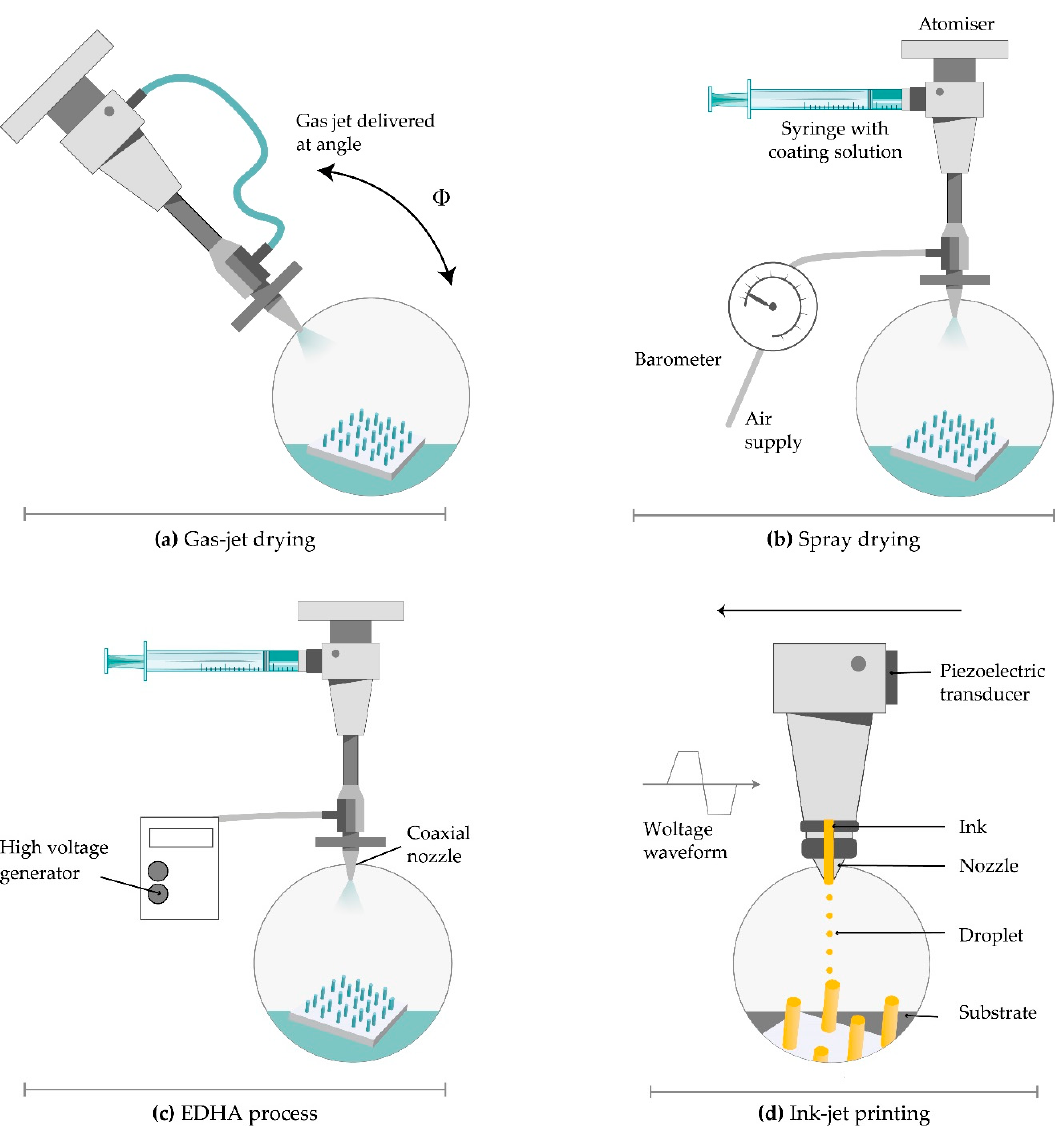
Figure 9. Coating techniques for MNs. ( a ) gas-jet drying; ( b ) spray drying; ( c ) electrohydrodynamic atomization (EHDA) processes; ( d ) ink-jet printing.